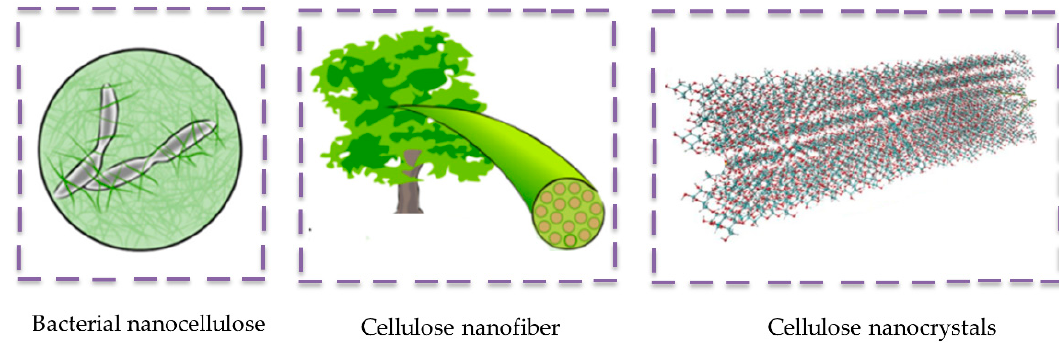
Figure 6. Images of bacterial nanocellulose, a cellulose nanofiber, and cellulose nanocrystals. Adapted with permission from reference [98,99]. Copyright MDPI, 2020 (BNC and CNF). Copyright NAS (National Academy of Sciences of United States of America), 2018 (CNC).